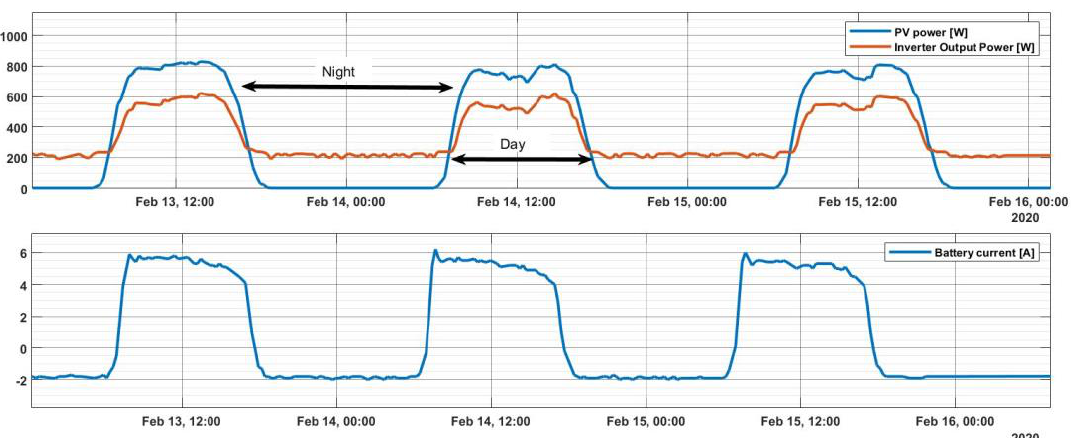
Figure 22. Microgrid PV system power and battery monitoring. The ( top ) plot shows the generated power from the PV panels and the output from the inverter. The ( bottom ) plot shows the current value on the battery side.